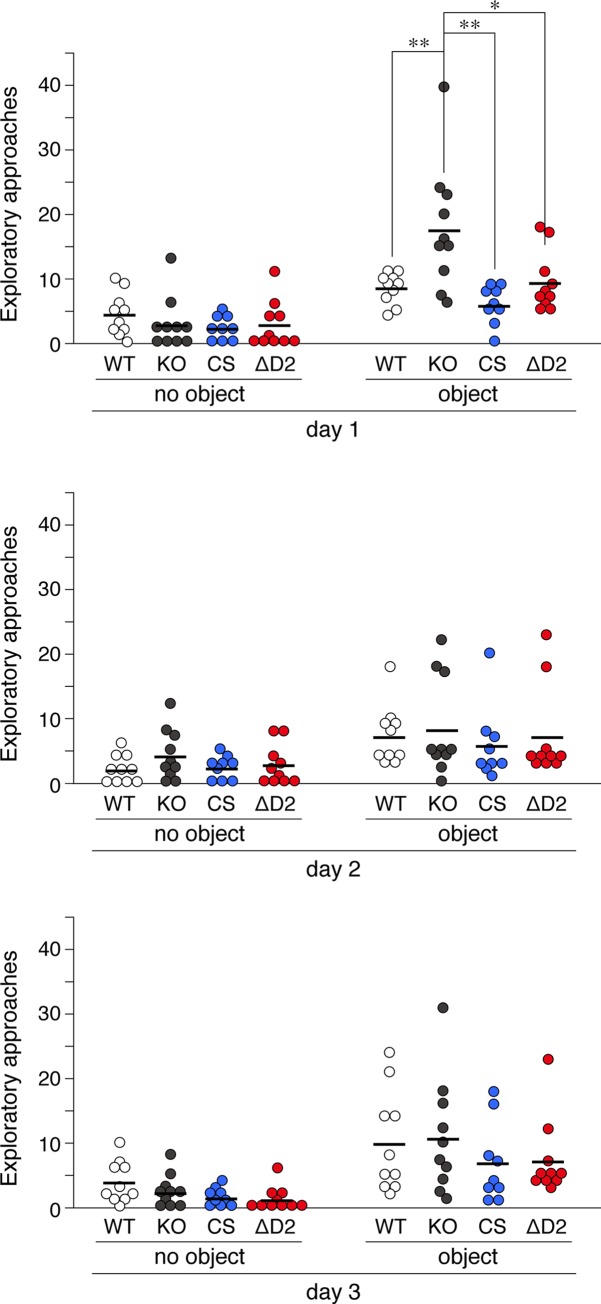
Novel object exploration test.Tests were performed in the same open field, first in the absence of an object for 9 min and then in its presence at the center for 9 min for 3 consecutive days. The scatter plot shows the individual values of exploratory activities with their mean (n = 9–10 animals per group). There were significant effects of object on all three days (Day 1, F(1, 35) = 71.992, P = 0.000; Day 2, F(1, 35) = 22.917, P = 0.000; Day 3, F(1, 35) = 38.217, P = 0.000), and significant effects of genotype on day 1, but not day 2 or 3 (Day 1, F(3, 35) = 4.175, P = 0.013; Day 2, F(3, 35) = 0.440, P = 0.726; Day 3, F(3, 35) = 1.049, P = 0.383) by a two-way mixed design ANOVA. *, P < 0.05; **, P < 0.01, significant difference between the indicated groups by Tukey’s HSD test.